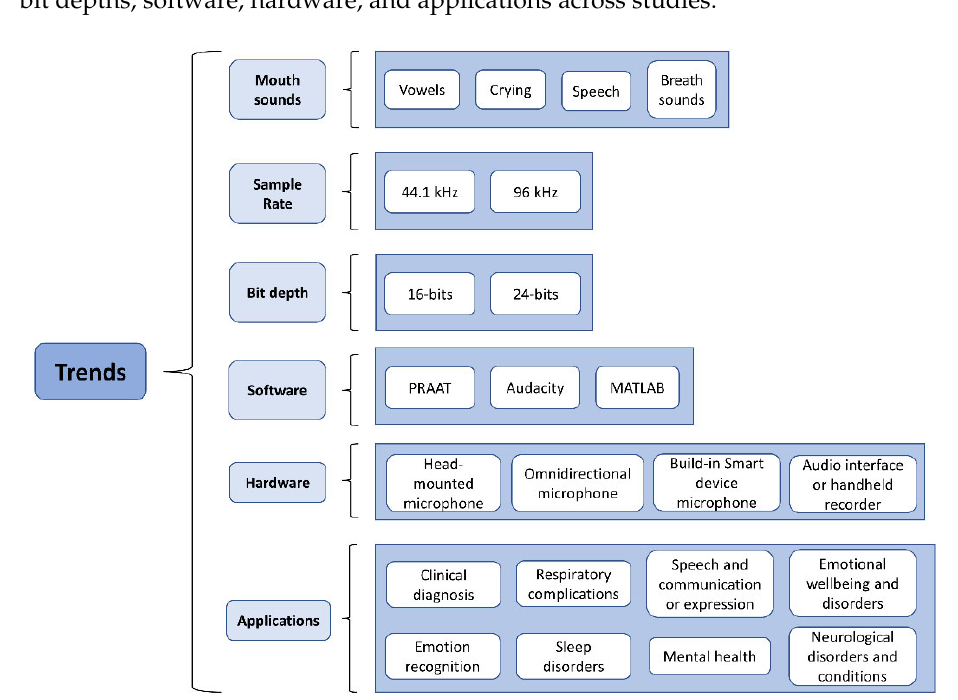
Figure 4. Most common trends across studies, from mouth sounds to applications. Here, important aspects regarding the processing and recording of mouth sounds, as well as the application of their analysis, are described.